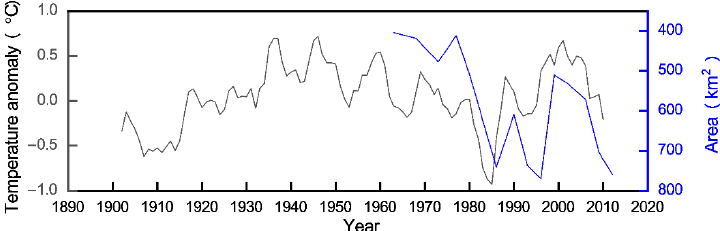
Figure 8. Comparison between the reconstructed T DS (black) and the area (blue) of in Ejina oasis. Black line represents 3-year moving average